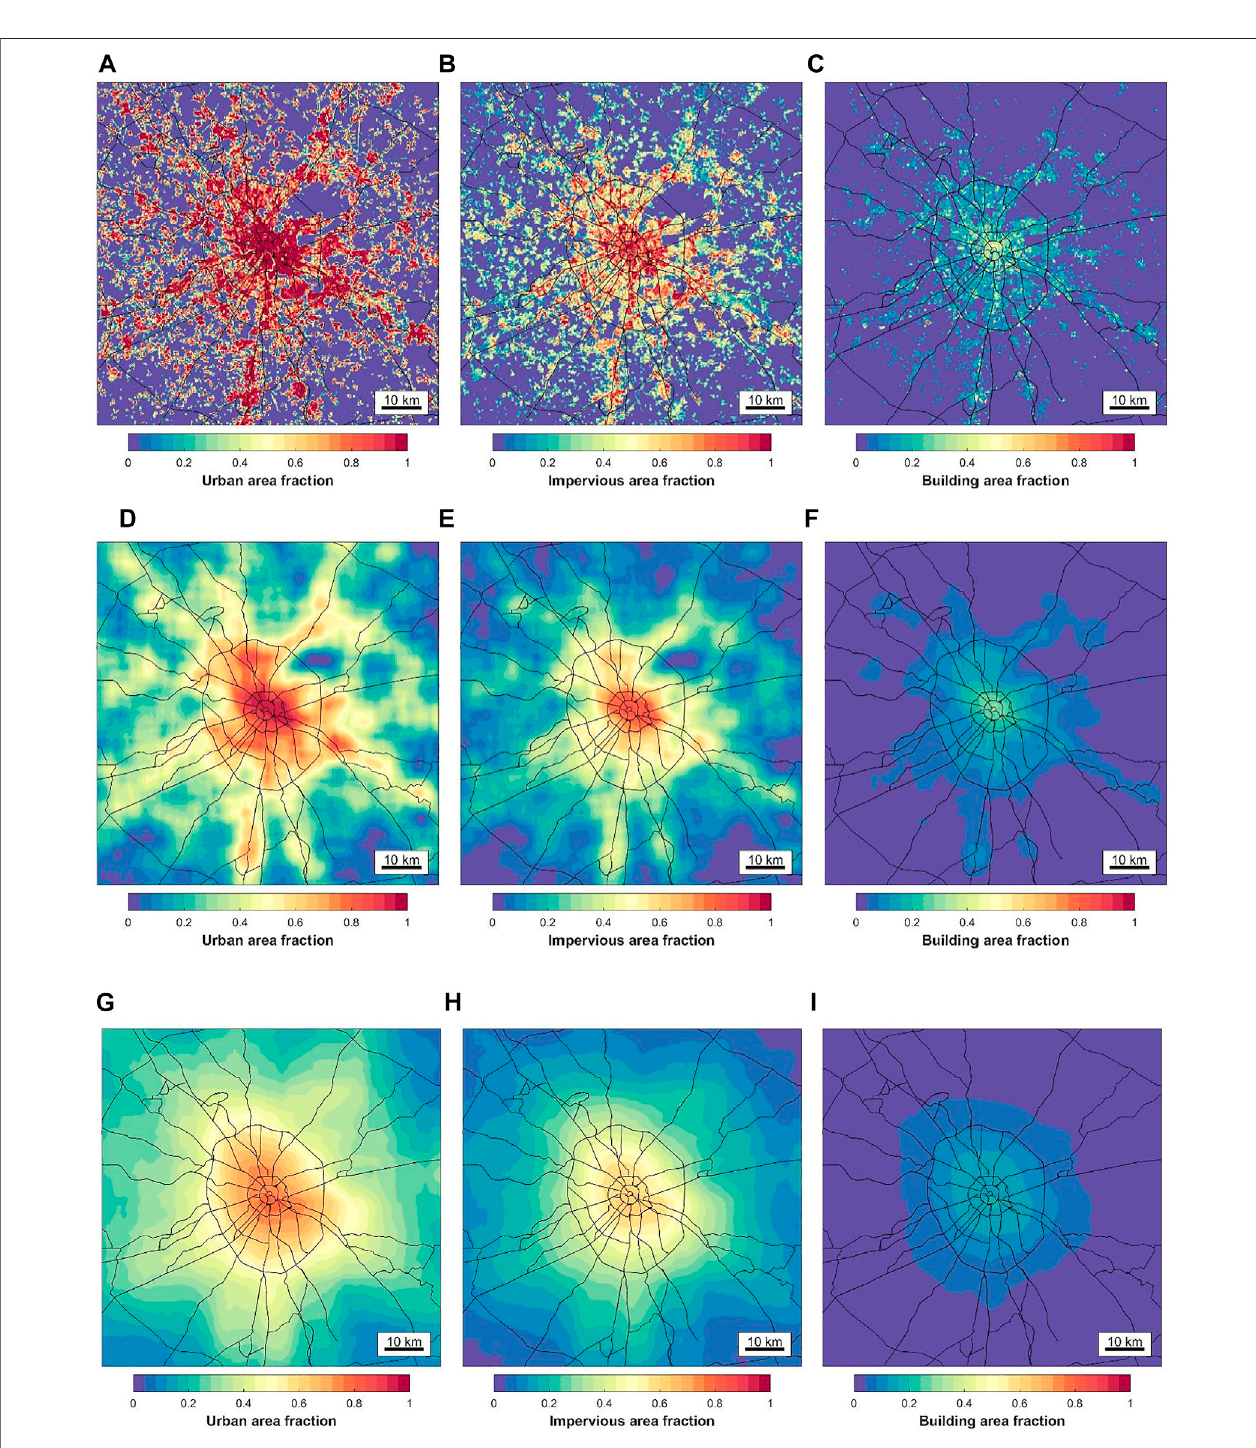
FIGURE 3 | Spatial distribution of city-descriptive parameters λ urb (A, D, G) , λ ISA (B, E, H), and λ bld (C, F, I) on the original 250-m grid and after smoothing within a radii of 3 km (A – D) and 10 km (G – I) .